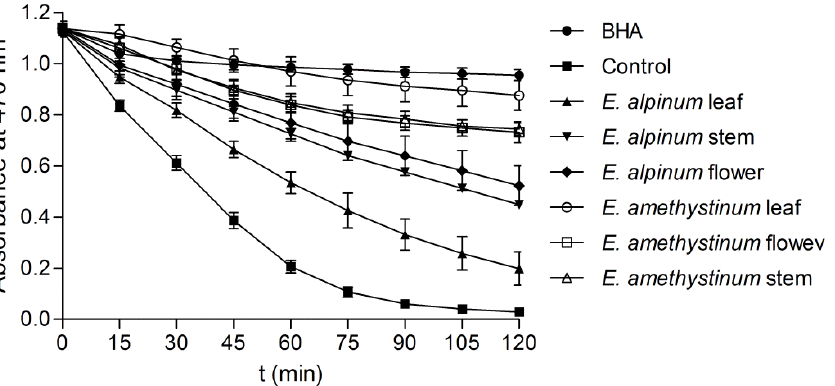
Figure 1. The reduction of absorbance of β -carotene-linoleic acid emulsion caused by Eryngium spp. extracts. Each value represents the mean of three independent measurements with SD error bar.